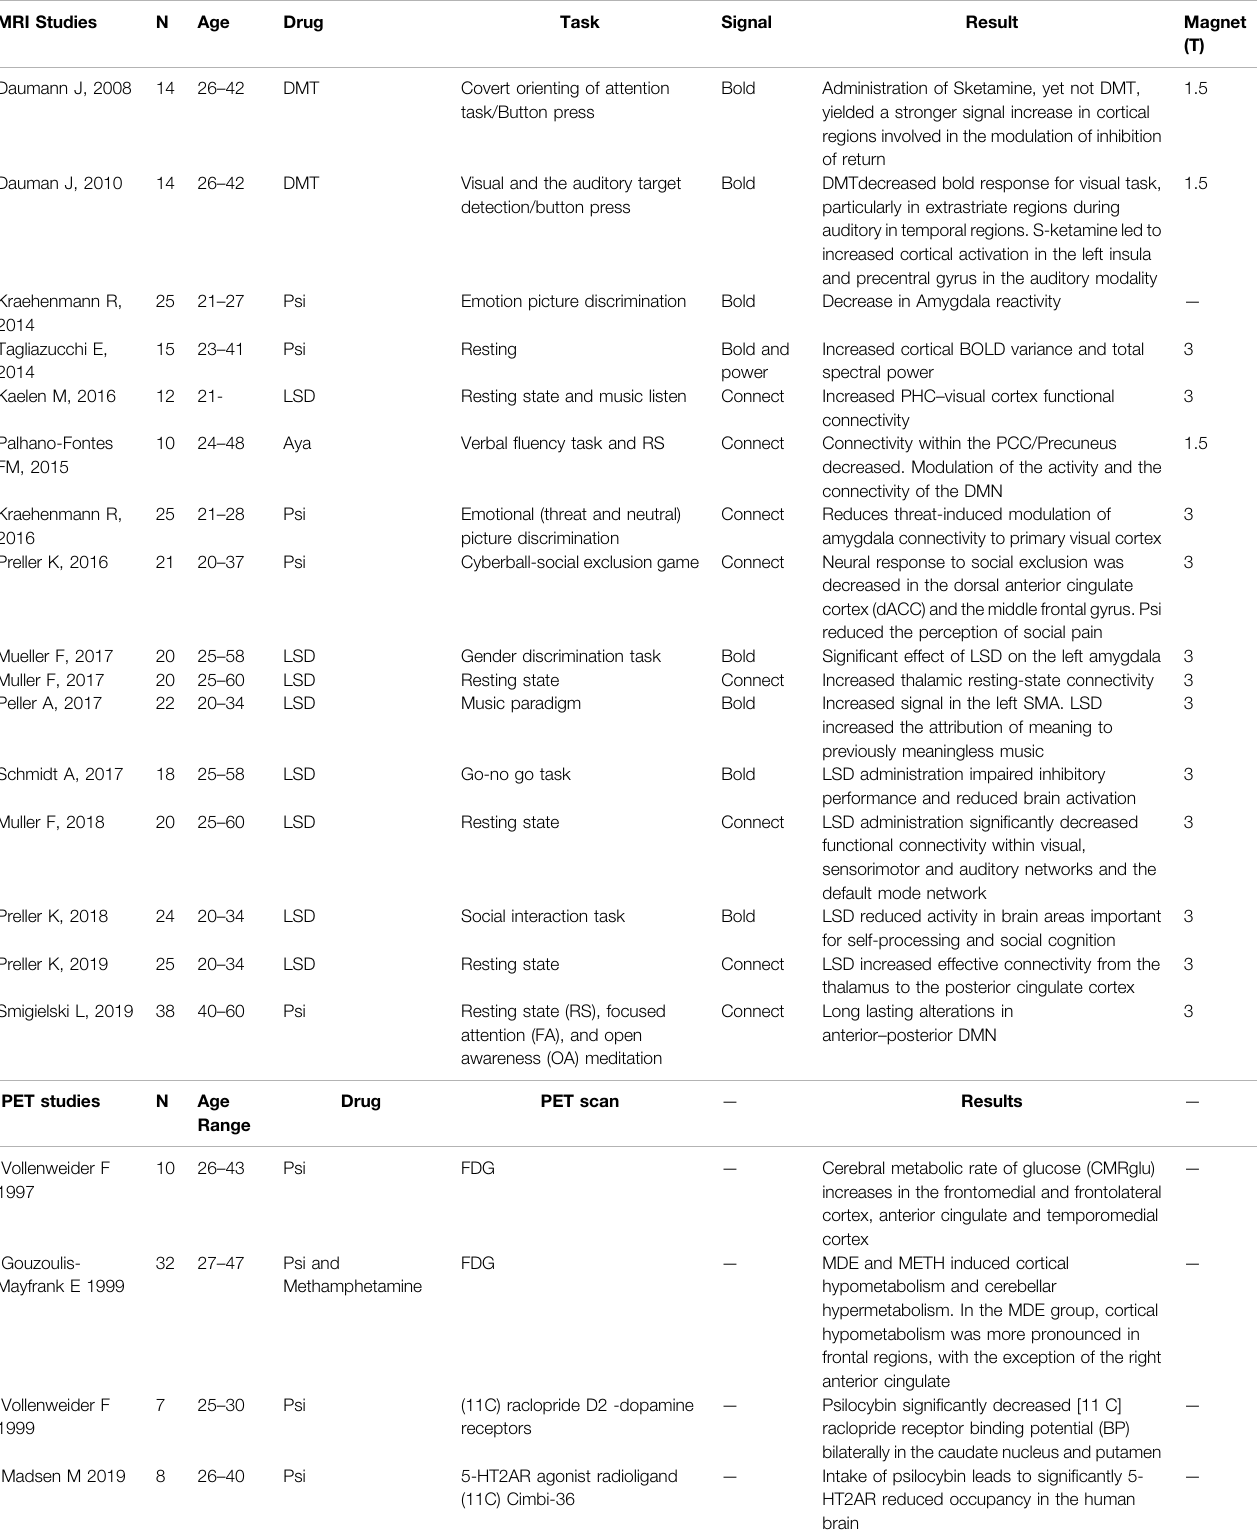
TABLE 1 | Summary of studies included in the review . The studies detail and individual results are